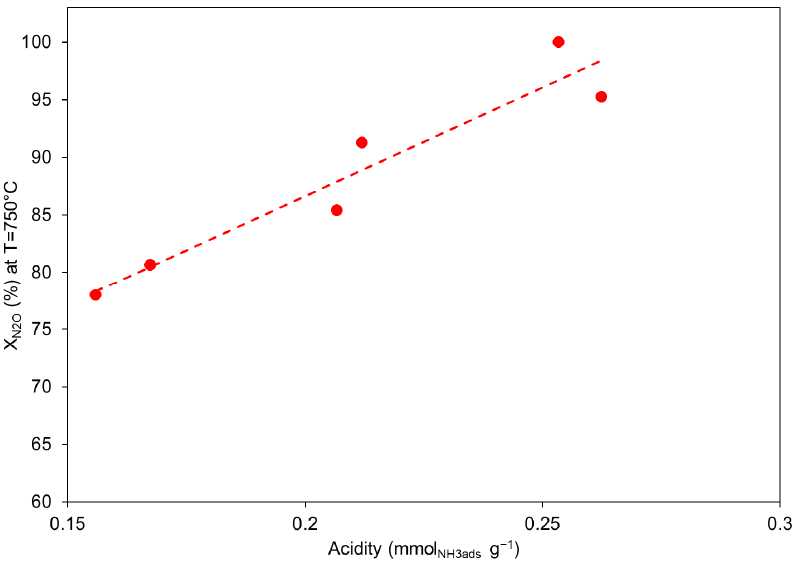
Figure 7. N 2 O conversion values (at fixed temperature, 750 ◦ C) as a function of acidity (expressed in mmol NH3,ads · g − 1 ) of Fe / HAP